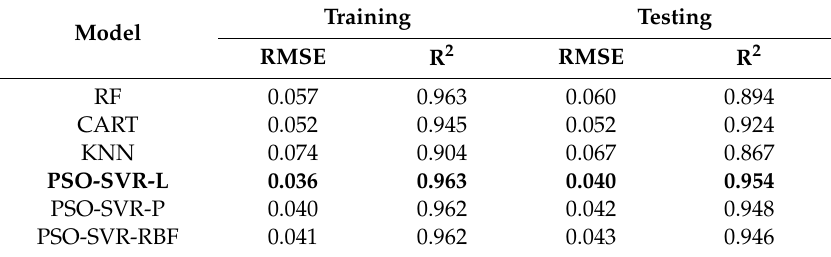
Table 5. Performance indices of the PM 10 concentration predictive models. Training Model